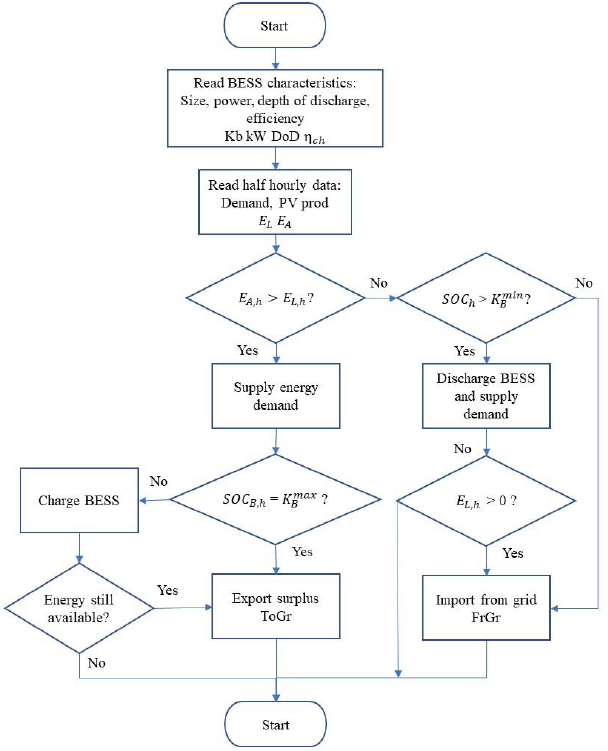
Figure 2. Energy flow chart for each half-hourly period.